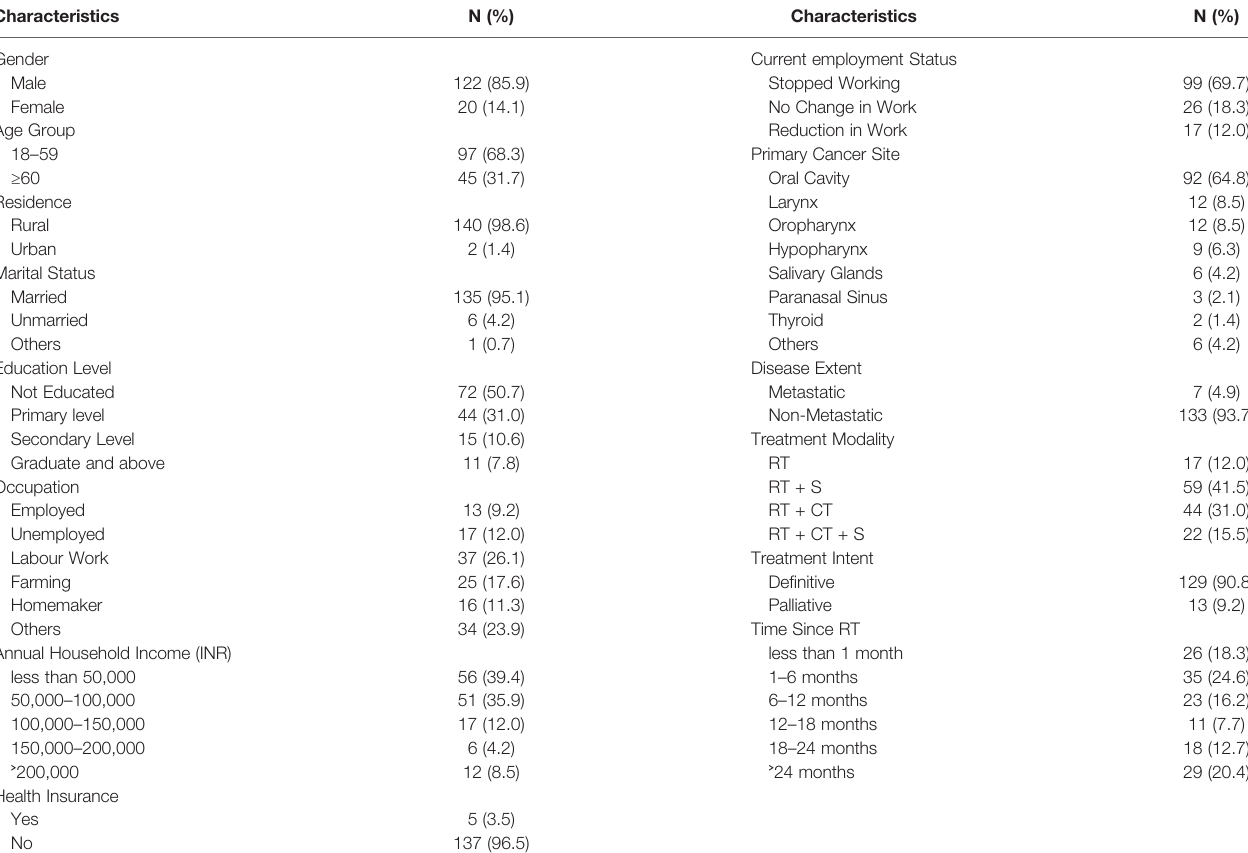
TABLE 1 | Sociodemographic and Clinical Characteristics ( N = 142). Characteristics